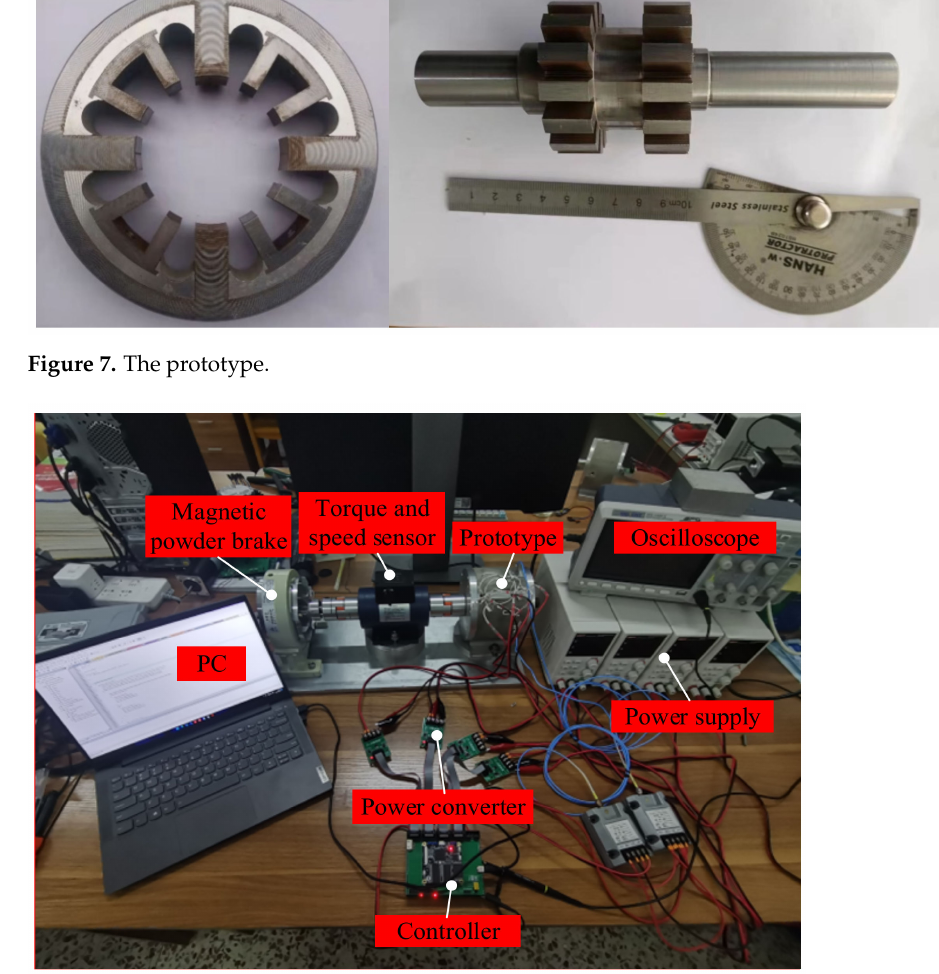
Figure 8. The experimental